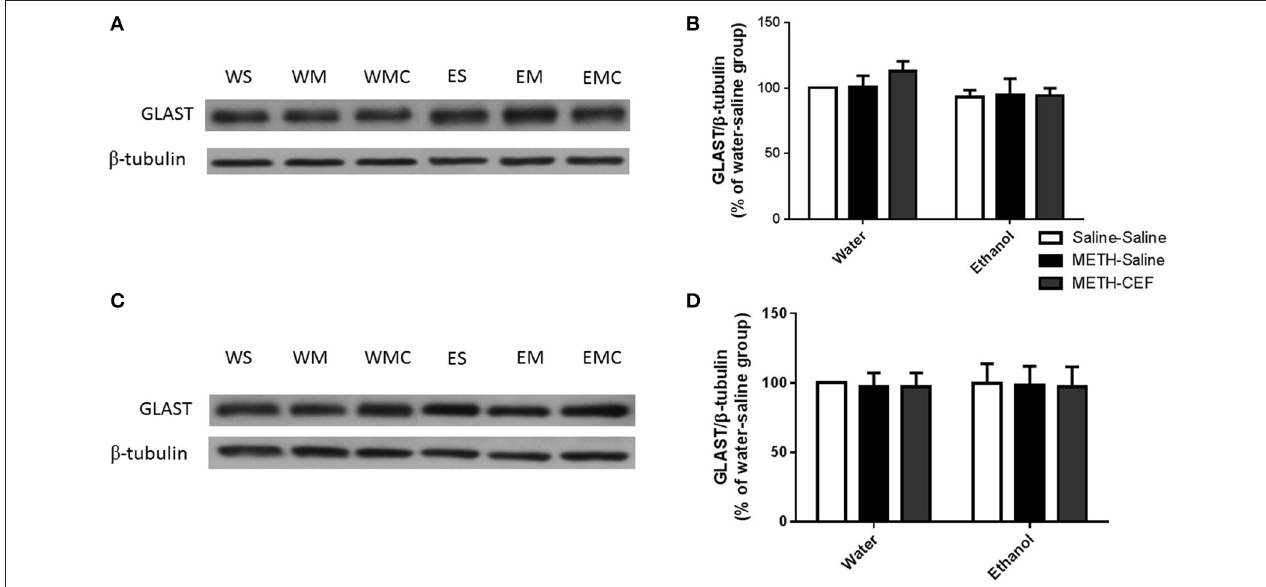
FIGURE 4 | Effects of METH (10mg/kg i.p. every 2h × 4), ethanol and CEF (200 mg/kg) on GLAST expression in the NAc and PFC. (A,C) Immunoblots for GLAST as well as β -tubulin, which was used as a control loading protein, in the NAc and PFC, respectively, as compared to water-pretreated groups and ethanol-pretreated groups. (B,D) Quantitative analysis did not reveal any significant differences in the ratio of GLAST/ β -tubulin among all groups in the NAc and PFC, respectively. Values shown as means ± S.E.M. n = 6 for each group.